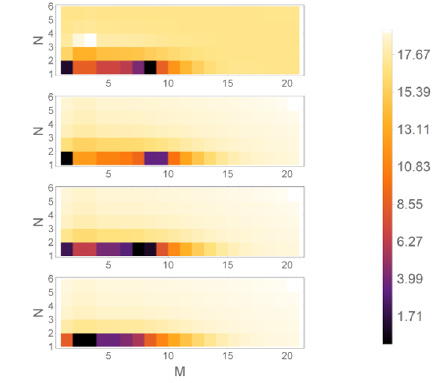
Figure 4 . Similar to (cid:12)gure 3 but for the case of (cid:17) =